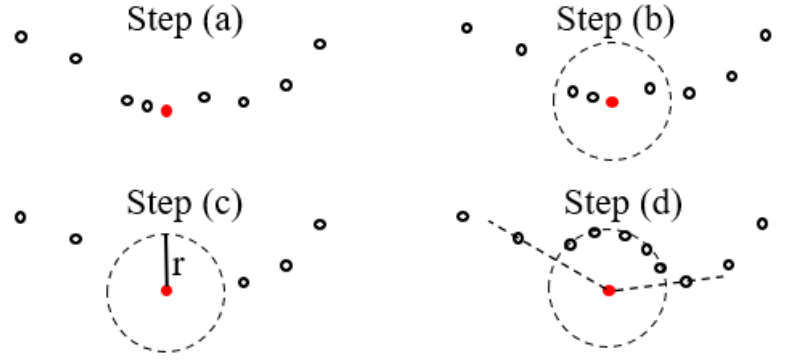
Figure 2. Generation process for the Poisson disk algorithm [28]. The red solid point is the DDP, and the black hollow points are PDPs. the black hollow points are